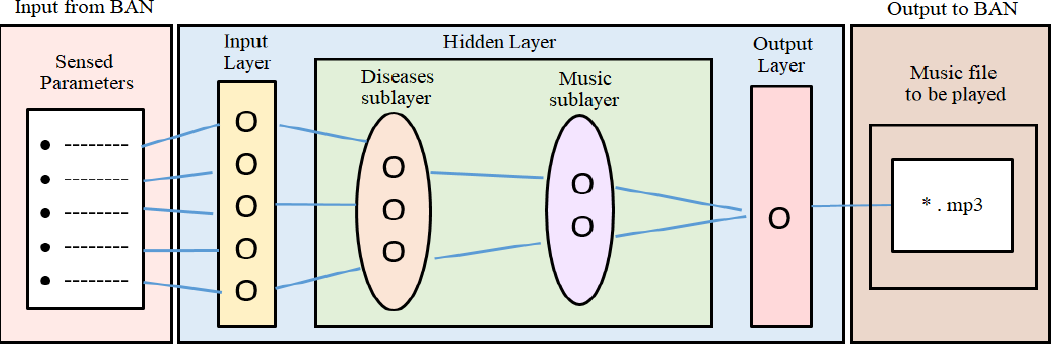
Figure 2. Graphical illustration of proposed ANN enabled IoT Architecture for music